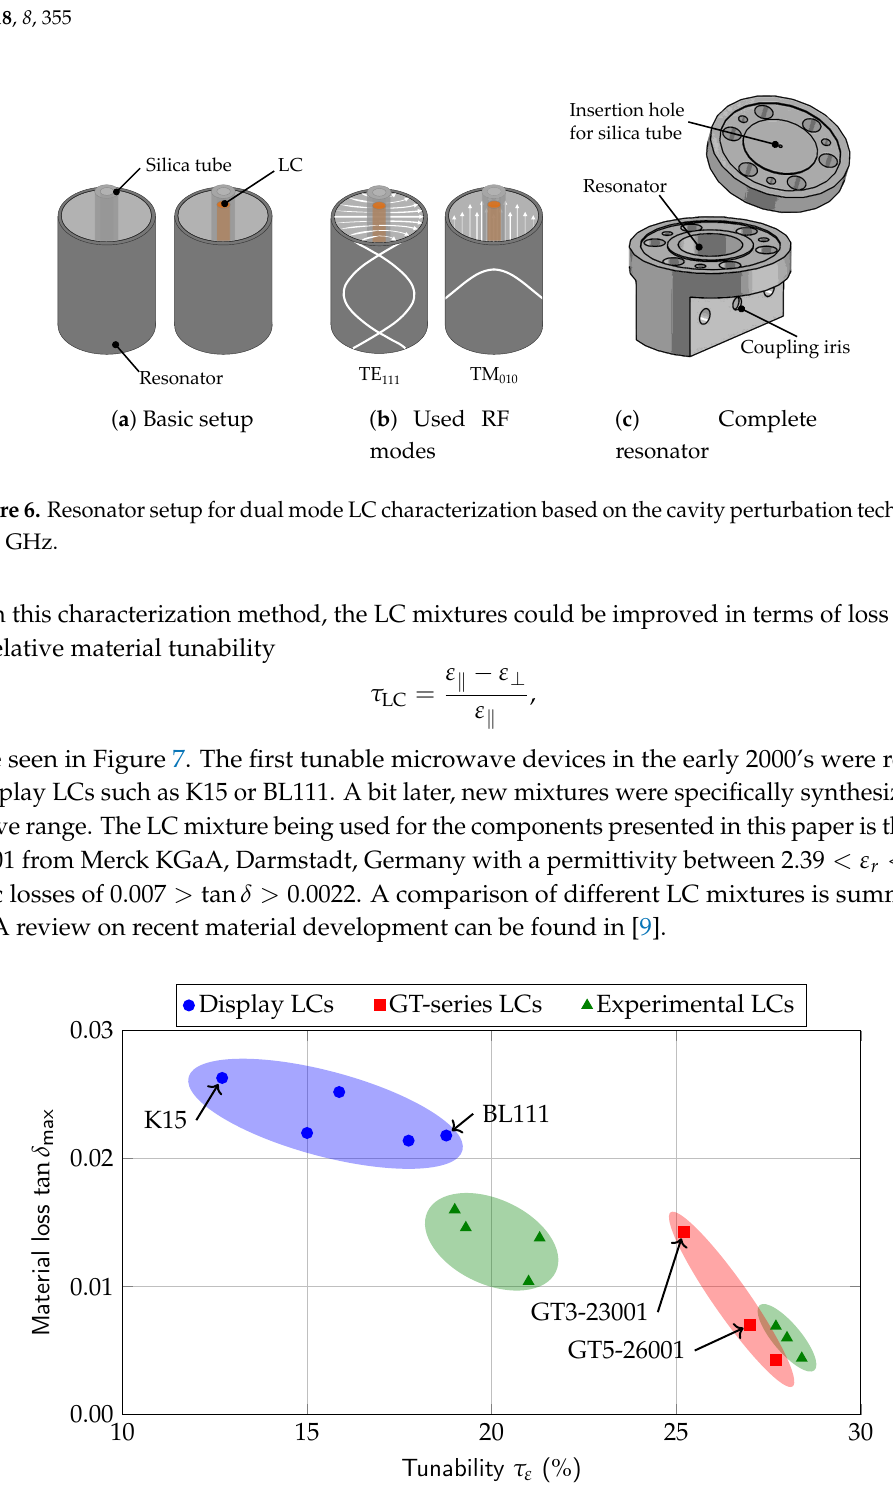
Figure 7. Development of LC’s microwave properties at 19 GHz from the early 2000’s where first display LCs have been used towards recent LC mixtures specifically synthesized for microwave applications. The mixtures were measured at room temperature.